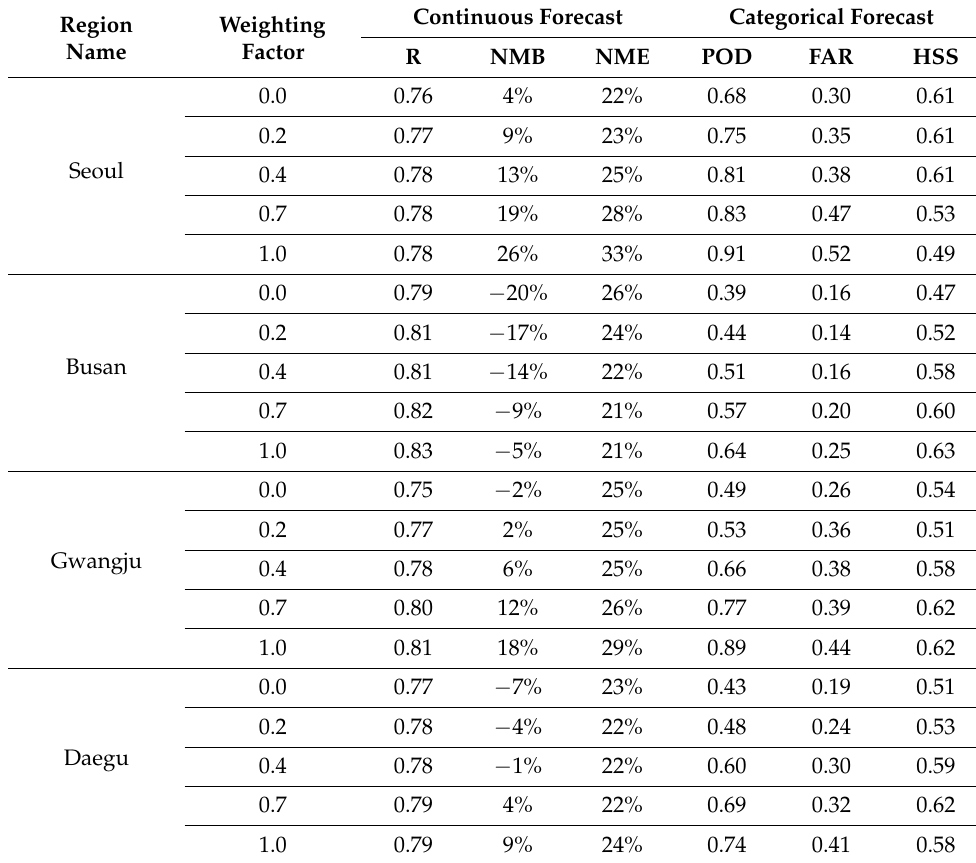
Table 3. Statistical analysis on the model performance in forecasting PM 2.5 concentration at four cities (Seoul, Busan, Gwangju, Daegu) in 2016 with the PWF changing from 0 to 1. Continuous Forecast Categorical Region Weighting Name Factor